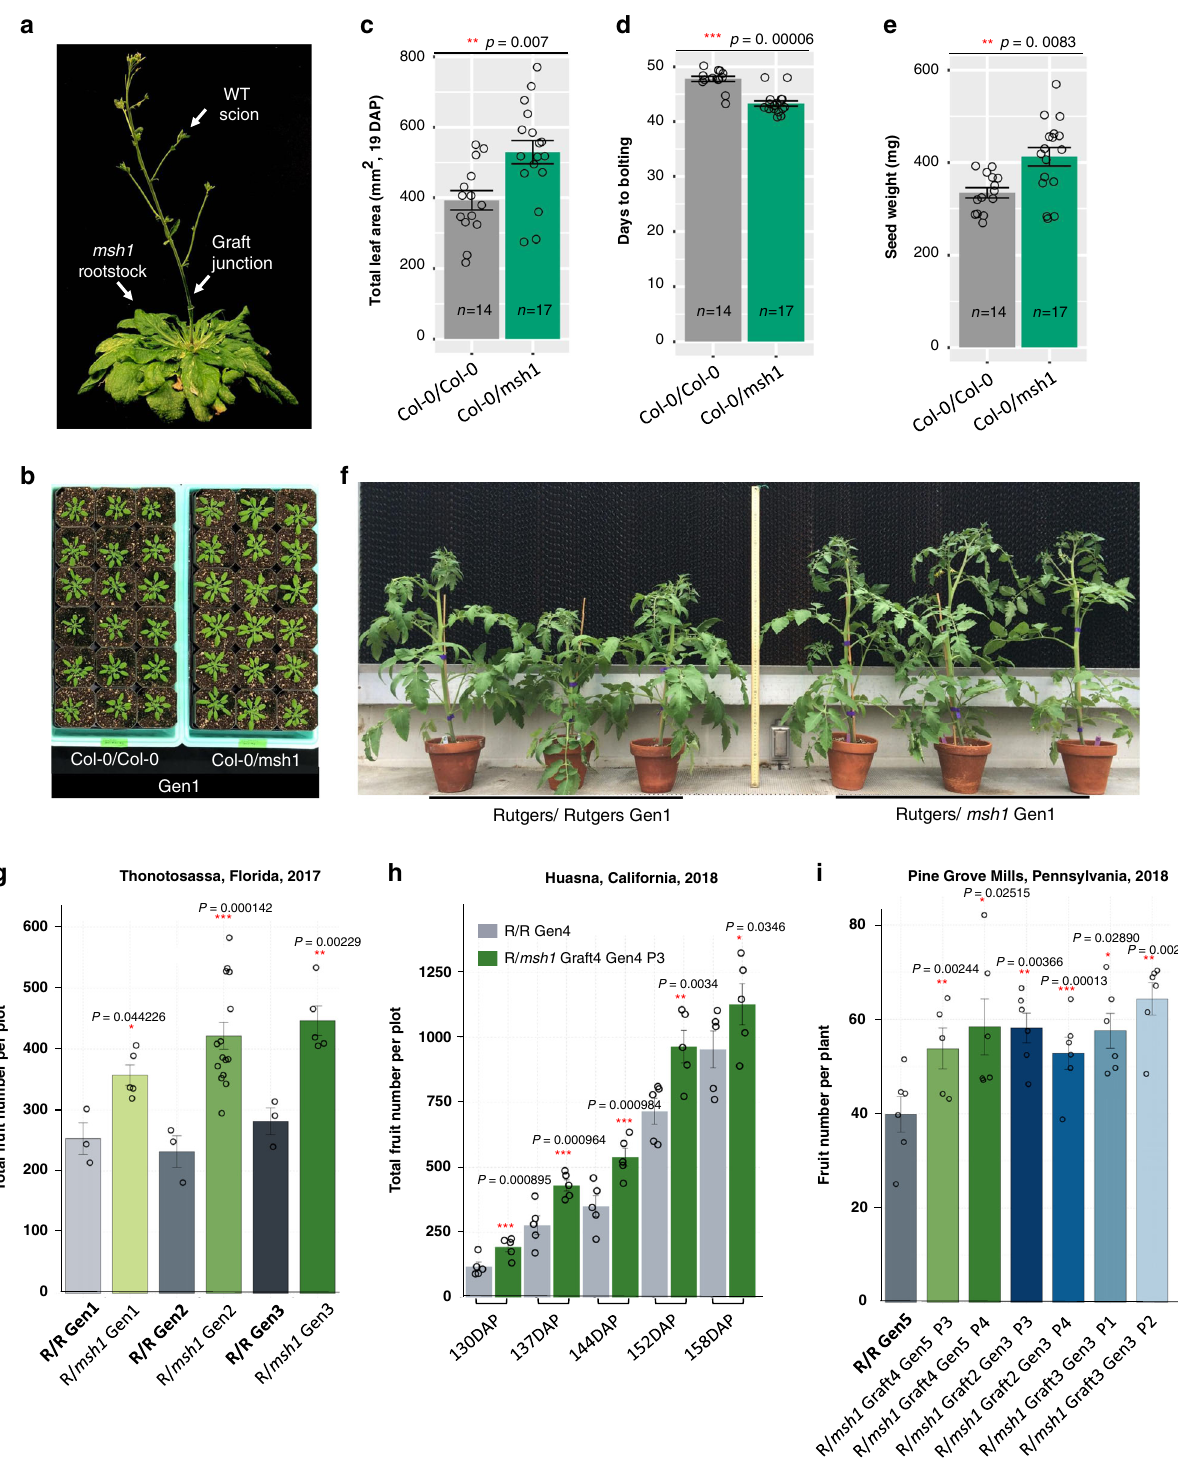
conditions. Graft progeny again outperformed the control (Fig. 1i and Supplementary Fig. 5). However, all experiments displayed variation in outcomes from graft progeny lines deriving from different parents and graft events (Supplementary Figs. 3 – 5), implying variation in the molecular events underpinning the HEG process. Graft progenies show differential gene expression in enriched pathways . To discover gene pathways contributing to the